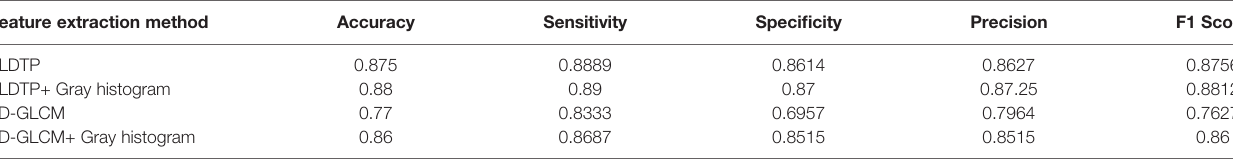
IOU, Intersection of Union, FPR, false positive rate.